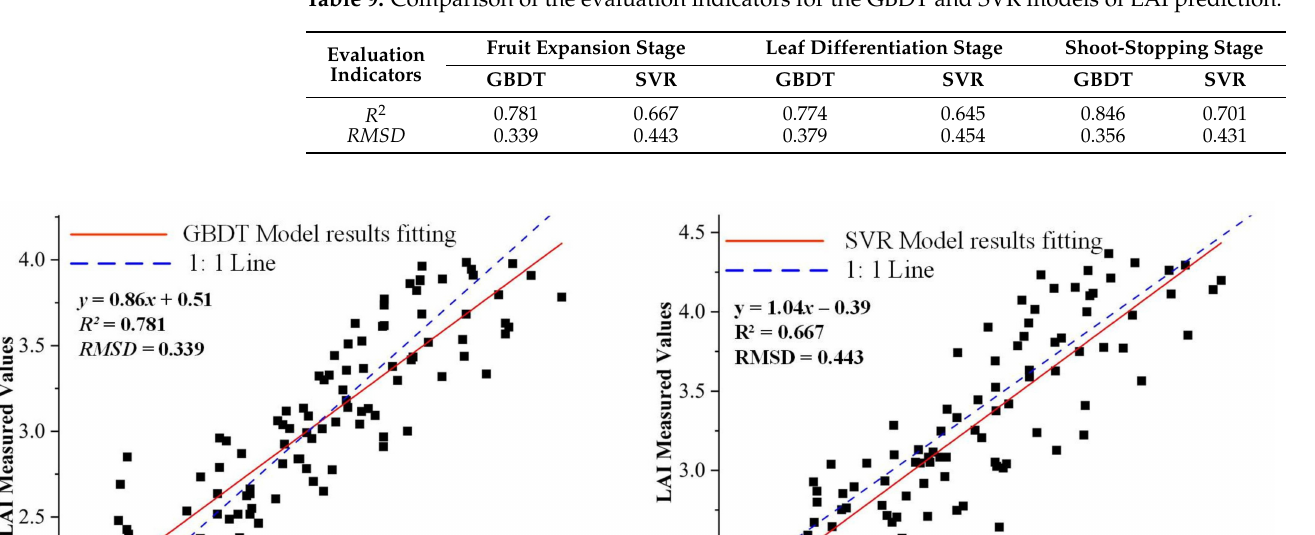
Table 9. Comparison of the evaluation indicators for the GBDT and SVR models of LAI prediction.